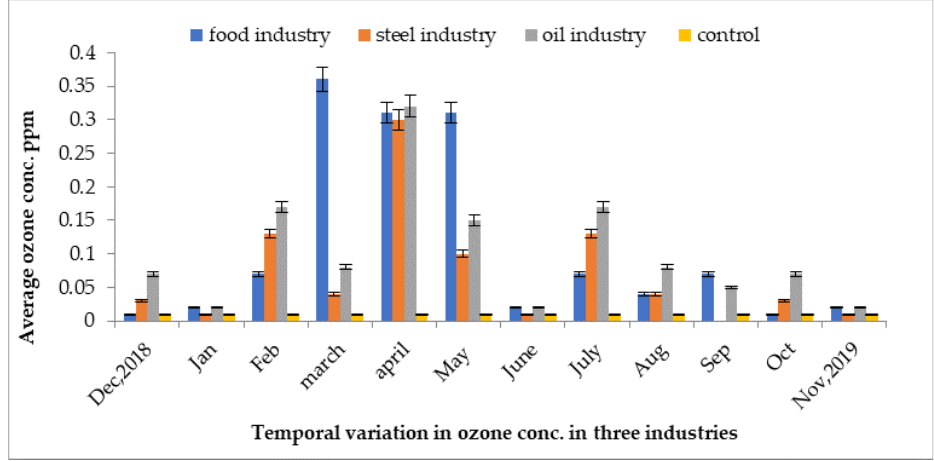
Figure 9. Variations in indoor and outdoor ozone concentrations in different units of food, steel, and oil industries from December 2018 to November 2019. oil industries from December 2018 to November 2019.